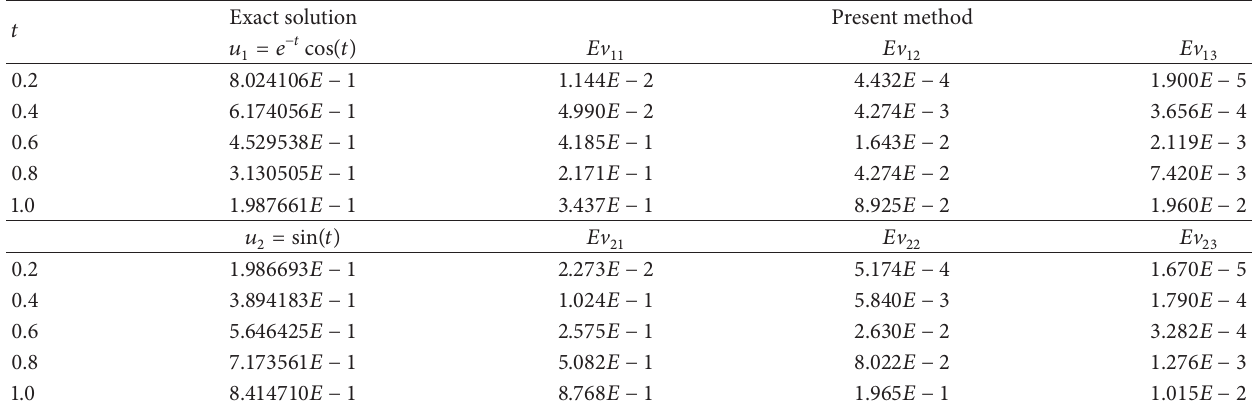
Table 4: The absolute errors for Example 4.